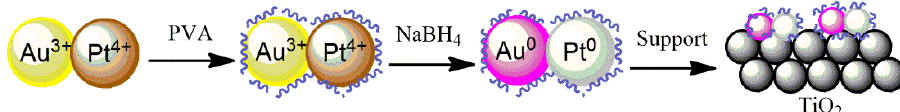
Figure 10. Method of sol-immobilization with PVA for Au-Pt/TiO 2 systems. Three different metal loadings were studied: 0.5 wt.%, 1.25 wt.%, and 2 wt.%. The